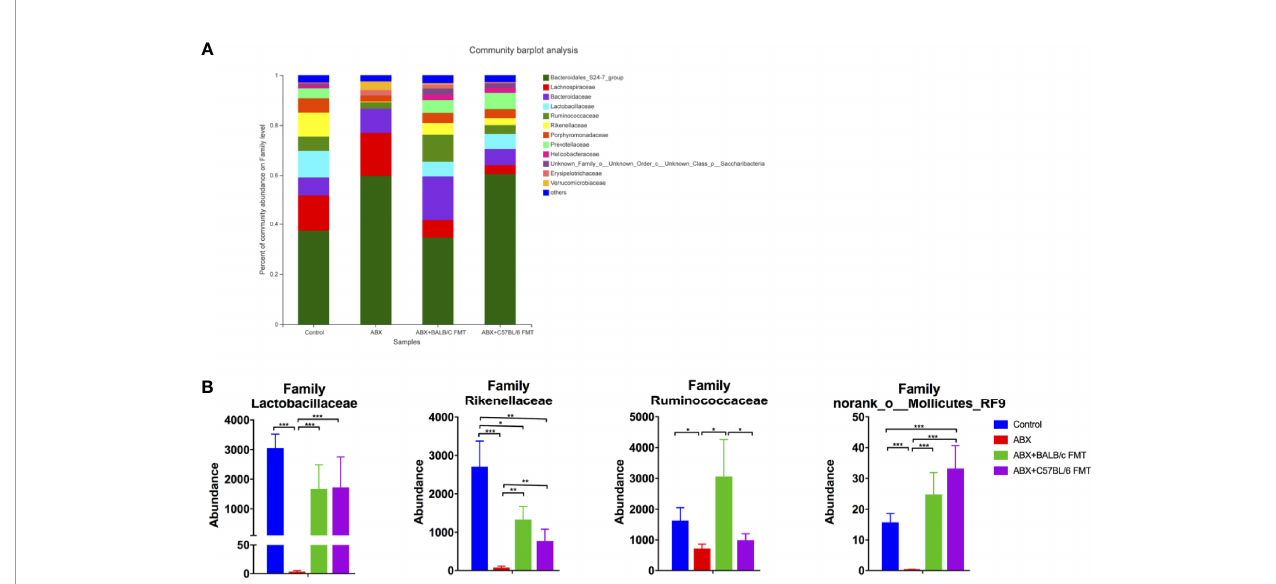
FIGURE 6 | Comparison of the gut microbiota composition at the family level after FMT. Gut microbiota composition at the family level (A) and abundances of individual bacteria (B) after FMT (on day 35 as indicated in Figure 3A ). n = 4 in control group. n = 5 in ABX, ABX+BALB/c FMT, ABX+C57BL/6 groups. * P < 0.05, ** P < 0.01, ***P <